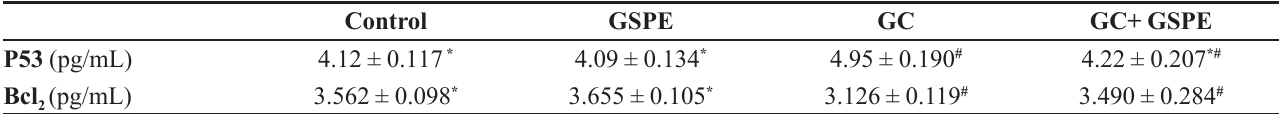
) levels in rat liver tissues in different group 2